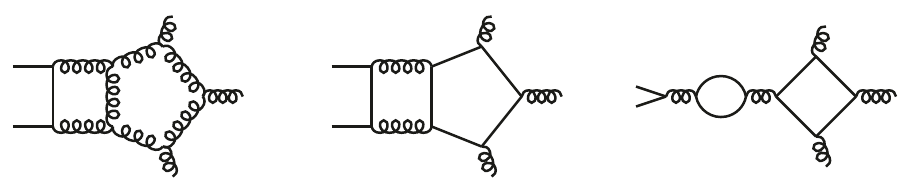
Figure 2 . Representative Feynman diagrams for leading-color A (2) ( q; (cid:22) q; g; g; g ) amplitudes, con- tributing at order N 0